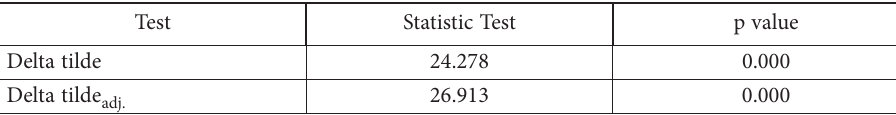
Table 4. Tests of homogeneity (H 0 : Slope coefficients are homogeneous) Test Statistic Test p value Delta tilde 24.278